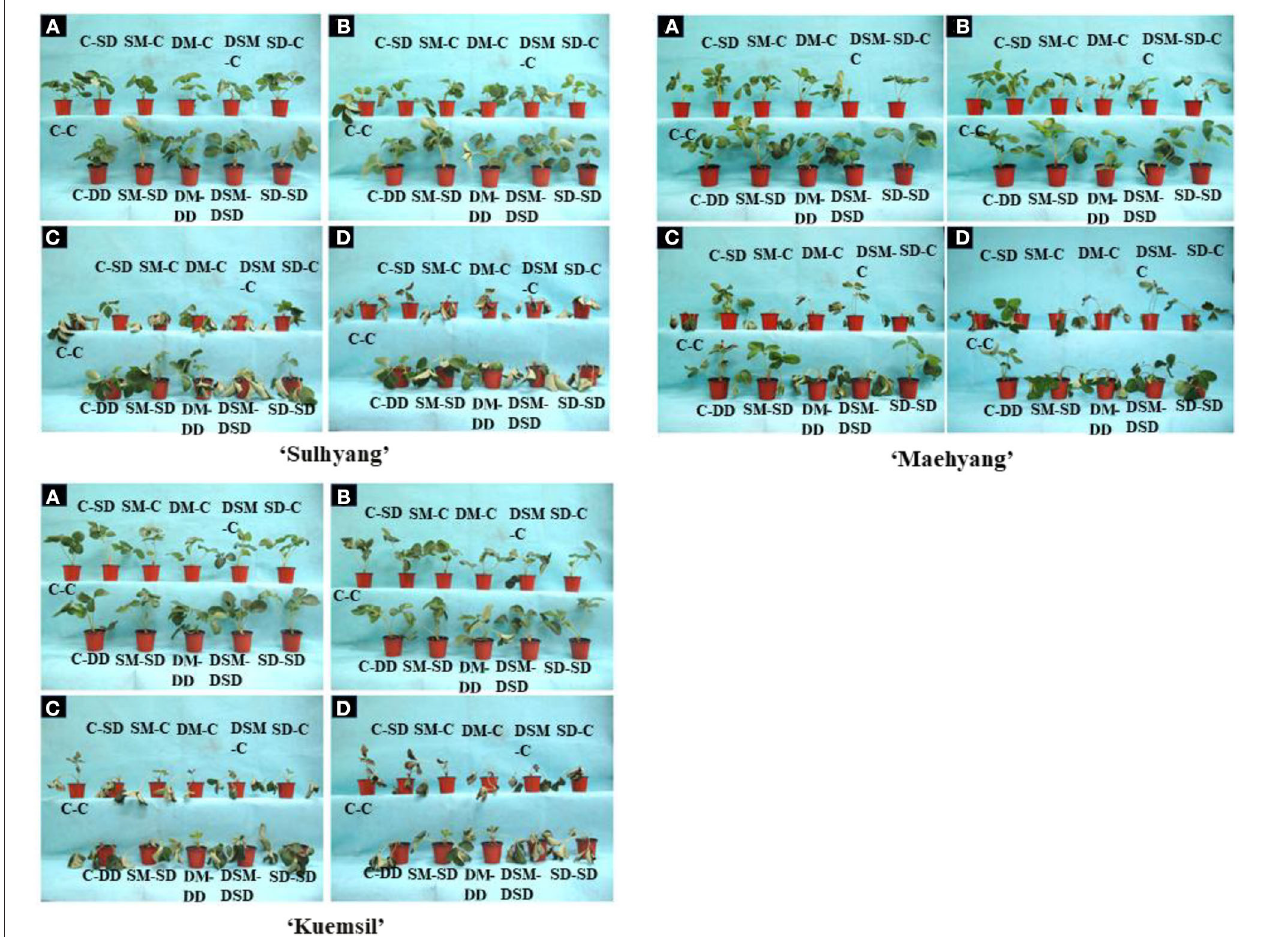
FIGURE 2 | Morphophysiological state as affected by the Si treatment in strawberry transplants after subjection to 43 ◦ C for 1 (A) , 3 (B) , 5 (C) , and 7 (D) days. See Figure 1 for descriptions of treatment